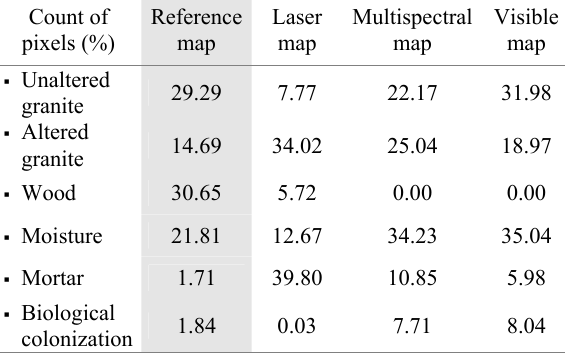
Table 2. Pixels computation belonging for each thematic class.